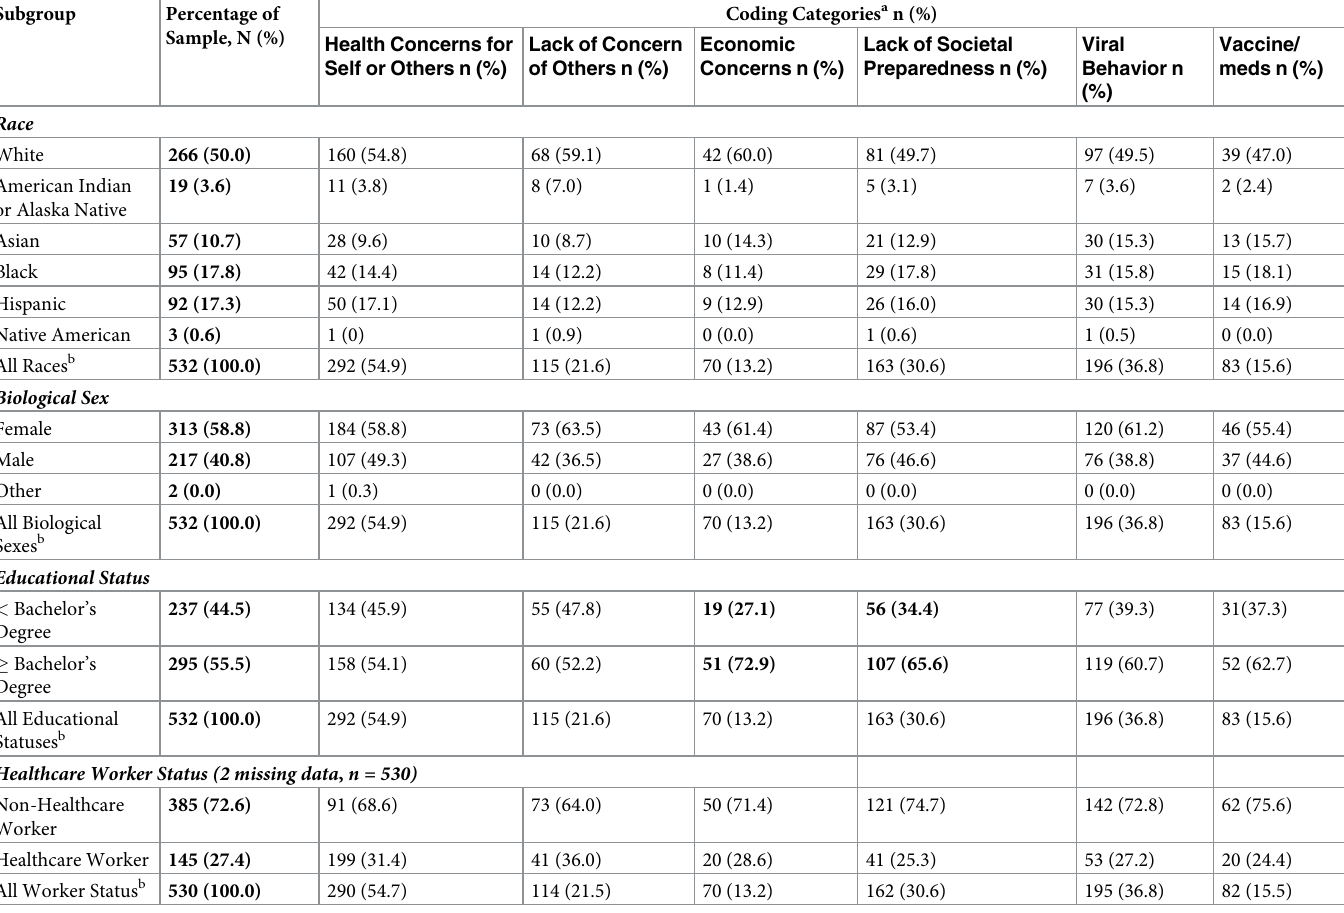
Table 2. Subgroup analysis showing frequencies of coding per subgroup across categories (N = 532) a